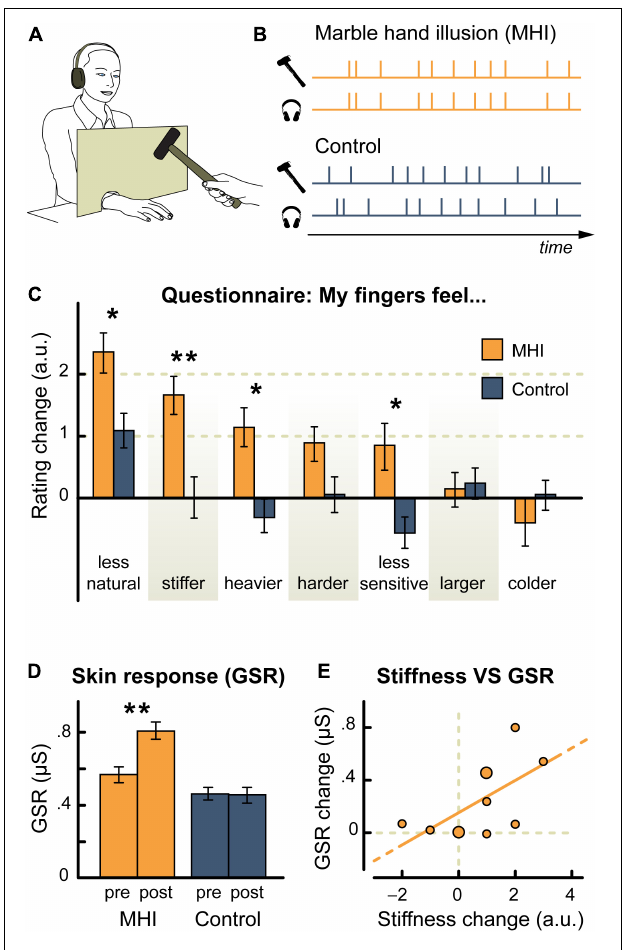
FIGURE 2 | Experimental set-up and results from Senna et al.’s (2014) marble hand illusion Experiment 1. (A) Experimental set-up; (B) Experimental conditions of temporally synchronous sound and skin tap (marble hand illusion) or asynchronous sound and touch (control); (C) Results for perceived finger properties assessed via questionnaire (Mean change [post- minus pre-testing] ± standard error of the mean); ∗ p < 0.05; ∗∗ p < 0.01; (D) Results for arousal to a threatening stimuli as measured using galvanic skin response (GSR), with findings showing an increase in arousal for the marble hand illusion condition but not the control condition (mean and standard error of the mean shown); (E) Relationship between perceived hand stiffness and mean arousal (GSR) for the marble hand illusion condition. A positive significant correlation (Pearson’s r = 0.6, p = 0.02) was found between changes in perceived hand stiffness and changes in arousal (larger dots represent two points falling in close proximity). [Reproduction of Figure 1 of Senna et al. (2014). Reproduced via the Creative Commons Attribution (CC BY) License]. ∗ Color not needed for publication.